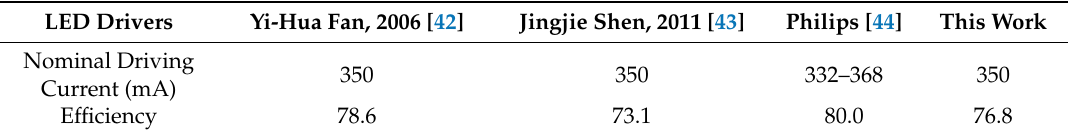
Table 1. Comparisons between on-board integrated LED drivers with the chosen technical